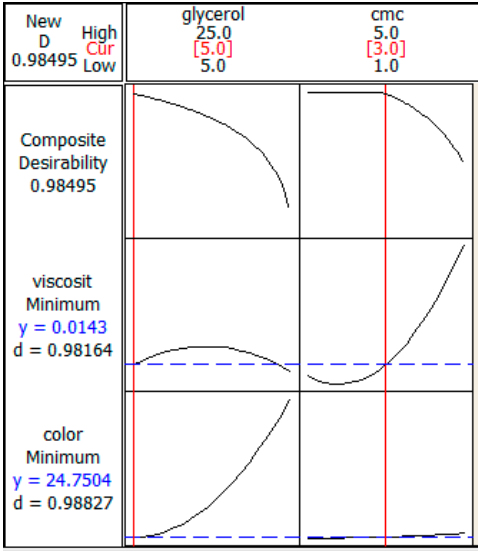
Figure 4. Optimization plot for glycerol and CMC.